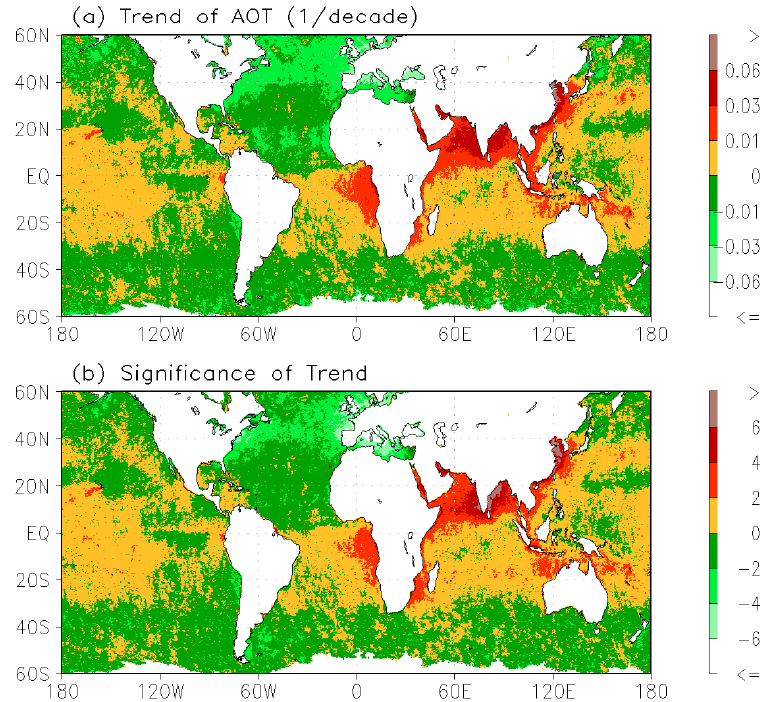
Figure 14. Global maps of ( a ) the linear trend and ( b ) the significance of the trend for AOT monthly mean values from 1981 to 2011. A significance >+2 (or < − 2) indicates the increasing (or decreasing) tendency detected is above 95% confidence level.